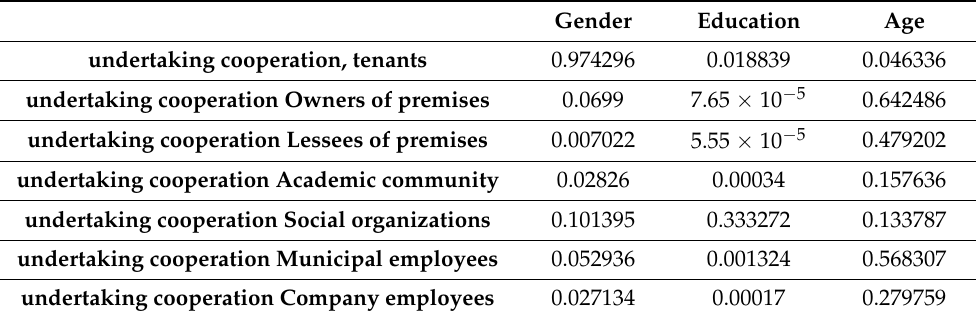
Table 8. Statistical significance and metrics.